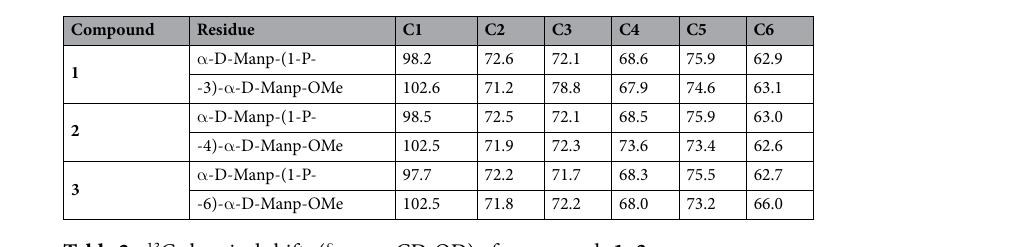
Table 2. 13 C chemical shifts ( δ , ppm; CD 3 OD) of compounds 1–3